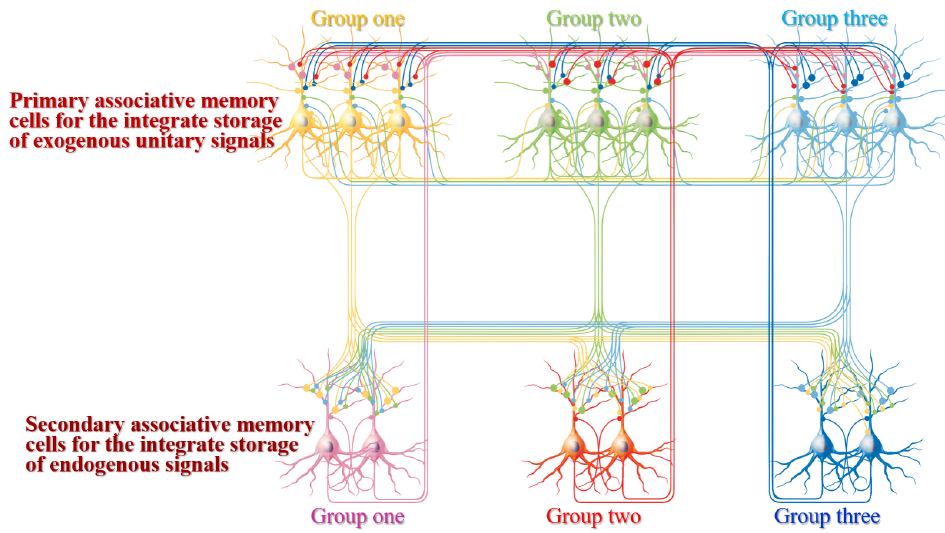
Figure 1. Associative memory cells and their connections. Three groups of primary associative memory cells (blue, green and yellow) in sensory cortices are synaptically innervated. Three groups of secondary associative memory cells (blue, red and pink) in brain areas relevant to cognition, emotion and behaviors are synaptically innervated. Mutual synapse innervations among associative memory cells in each group are intramodal, and mutual synapse innervations among three groups of associative memory cells are cross-modal. The axons of primary associative memory cells convergently and broadly innervate secondary associative memory cells, whose axons project back to primary associative memory cells. All neurons possess innate synapse innervations (yellow axons). The synapse innervations among the functional corresponding groups of primary and secondary associative memory cells are labeled by bigger presynaptic